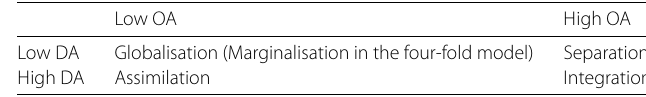
Table 1 Theories of integration and their relation to OA and